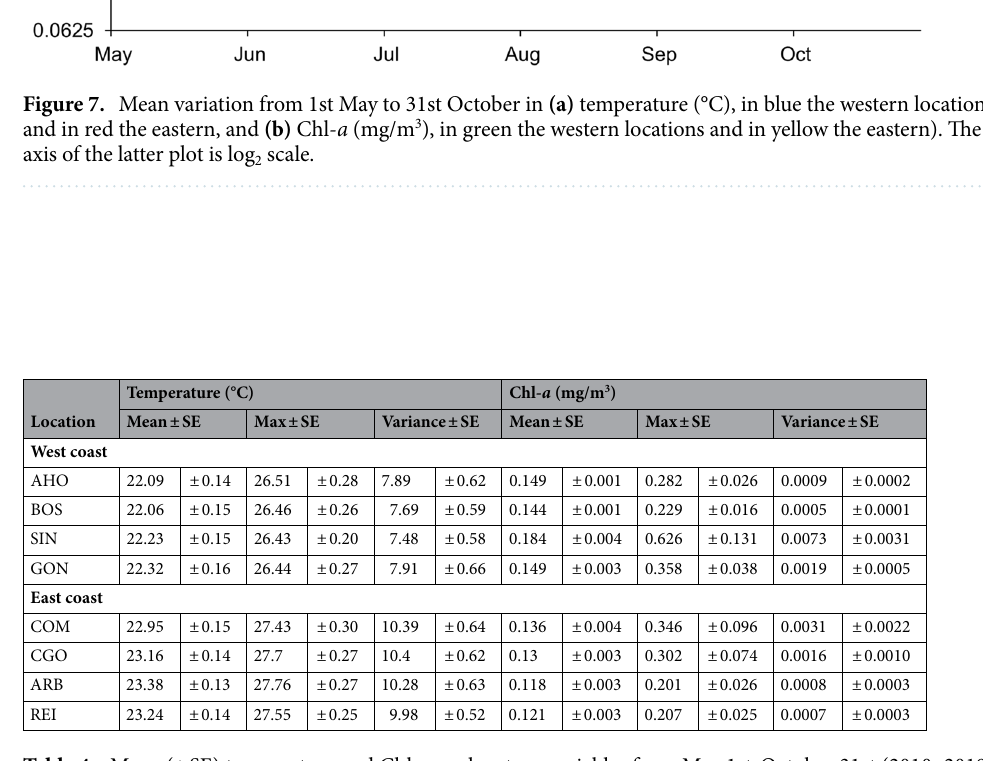
Table 4. Mean (± SE) temperature and Chl- a explanatory variables from May 1st-October 31st (2010–2019).